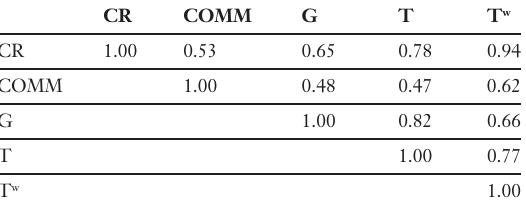
Pearson correlations between the Stan- dardised Clinical Exam CR, COMM, G, T and T w scores (n = 46).